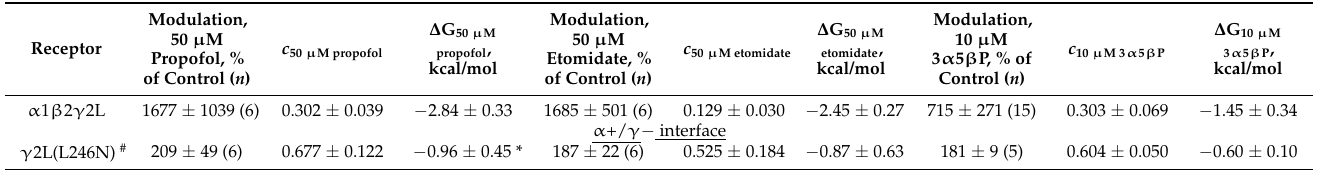
Table 2. Summary of effects of the γ 2(L246N) mutation to the α +/ γ − interface on GABA A receptor potentiation or direct activation by propofol, etomidate, and 3 α 5 β P.